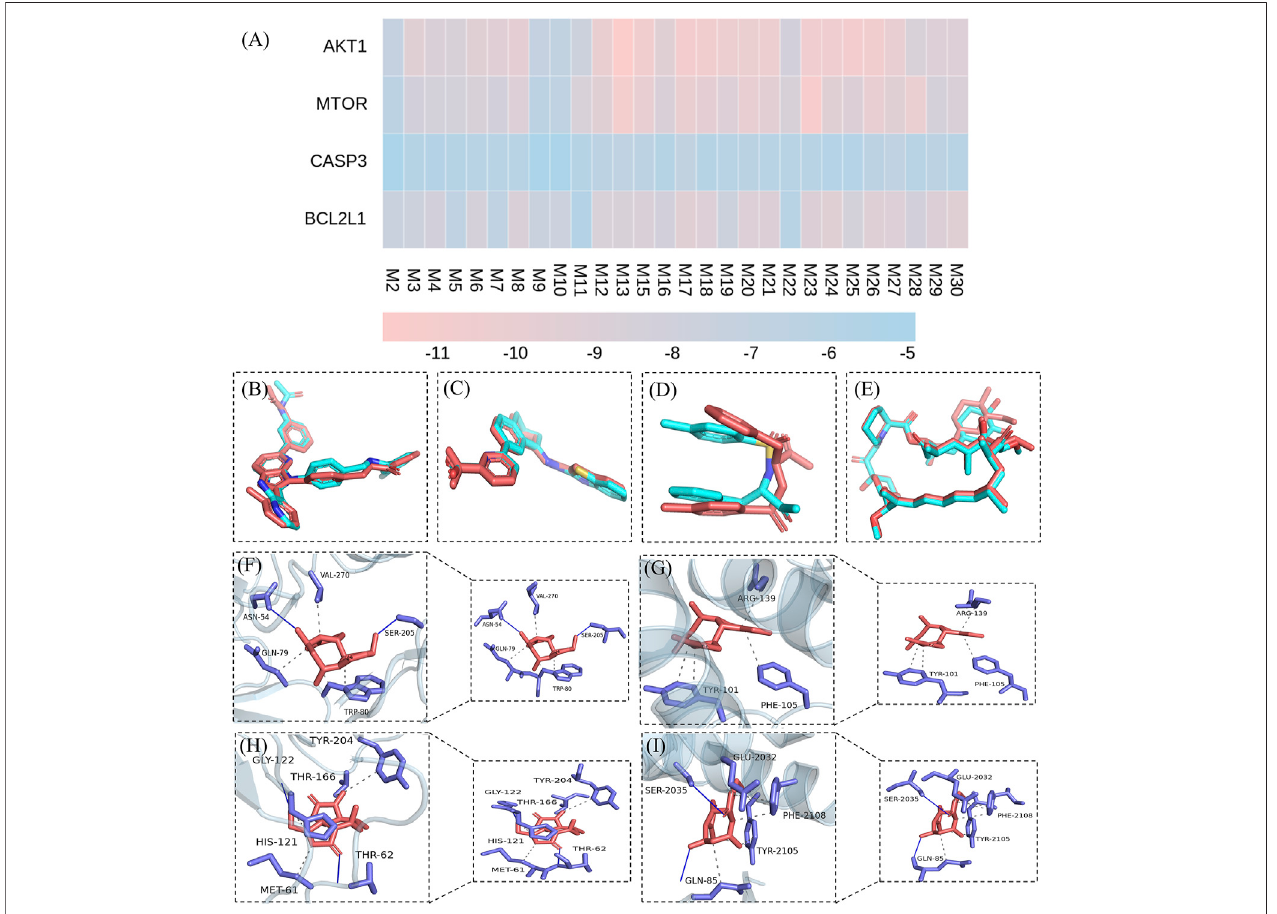
FIGURE 10 | Molecular docking results. (A) Binding energies between active components and targets (B) validation of the AKTI docking solution (C) validation of the BCL2L1 docking solution (D) validation of the CASP3 docking solution (E) validation of the mTOR docking solution (F) Stable complex formed by Lactucin and AKT1 (G) Stable complex formed by Lactucin and BCL2L1 (H) Stable complex formed by Lactucin and CASP3 (I) Stable complex formed by Lactucin and